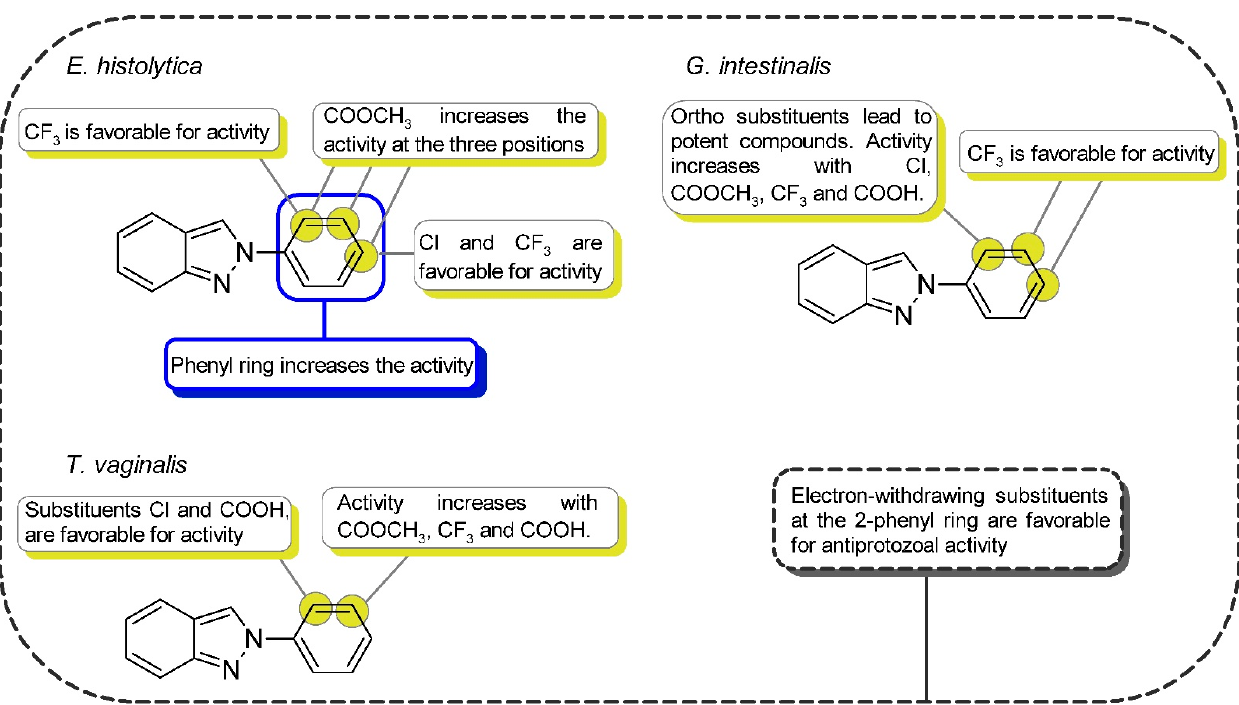
Figure 1 . Principally SAR features derived from the 2-phenyl-2 H -indazole derivatives tested. Figure 1. Principally SAR features derived from the 2-phenyl-2 H -indazole derivatives